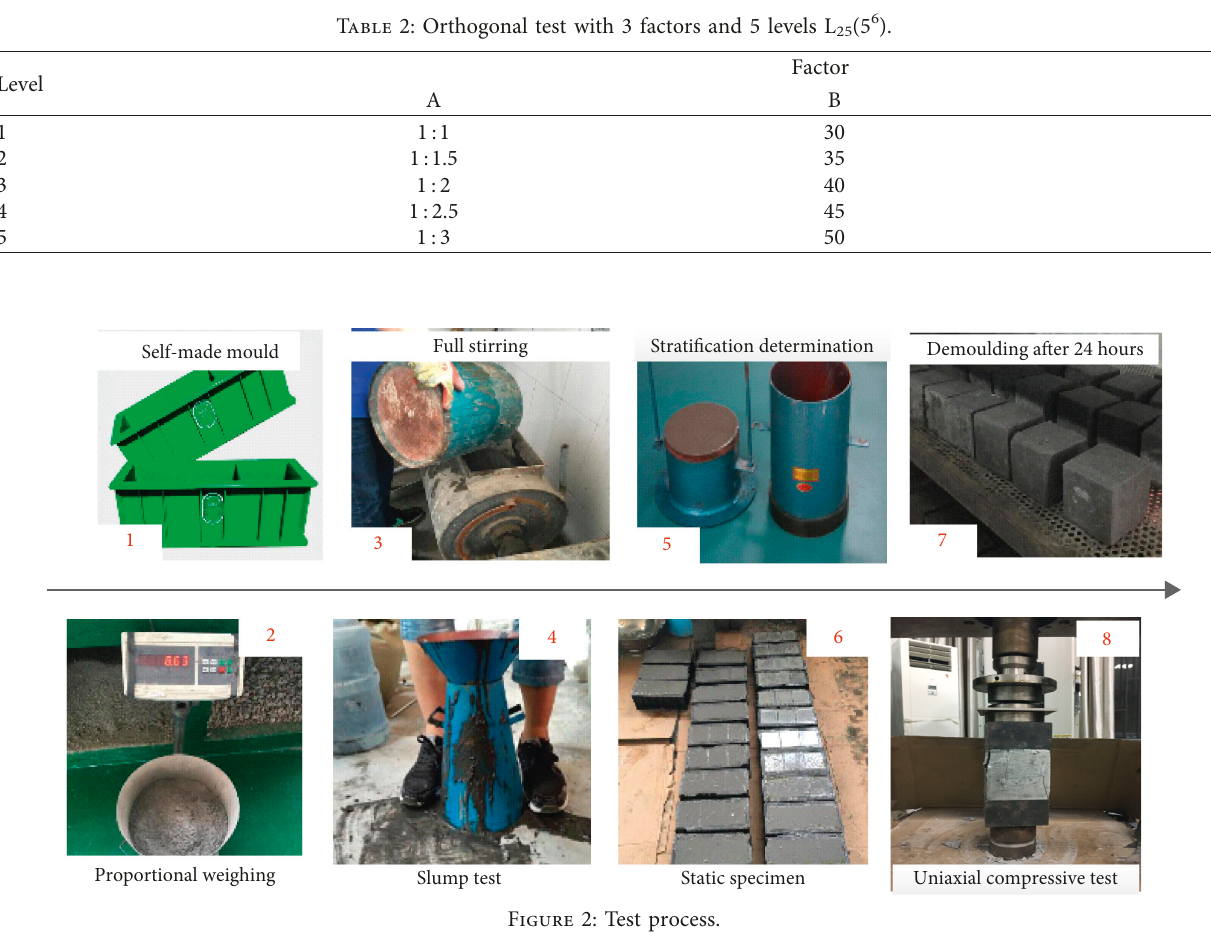
Table 2: Orthogonal test with 3 factors and 5 levels L